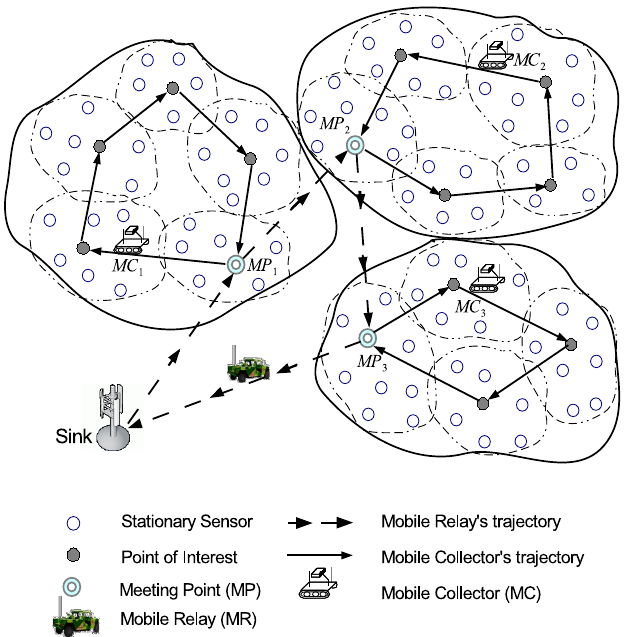
Figure 1. An overview of